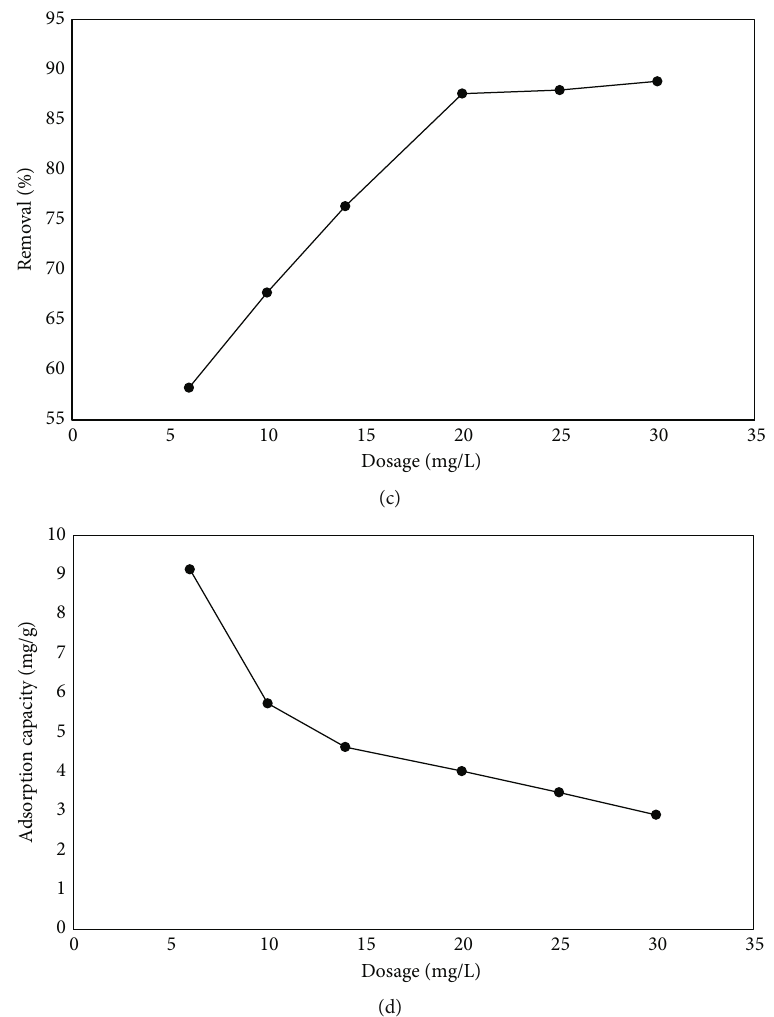
Figure 8: Study on e ff ect of pH towards MB removal (a) and adsorption capacity (b) for all nano fi bers (CA, GO functionalized CA nano fi ber, and GO functionalized CA with SOCX 1%,3%, and 5%). Static adsorption condition for pH study, dosage 6mg/L, concentration 10 ppm, and contact time 30 minutes. E ff ect of adsorbent dosage towards MB removal (c) and adsorption capacity (d) for GO functionalized CA with 1% of SOCX. Static adsorption condition for dosage study, pH 8 concentration 10 ppm, and contact time 30